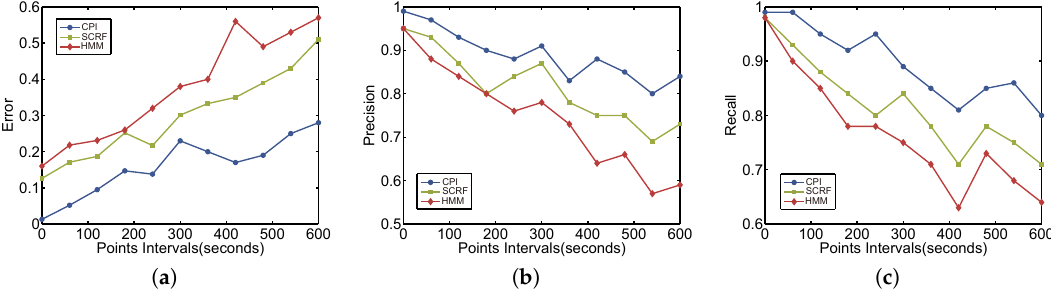
Figure 10. Experimental results by different sampling time intervals. ( a ) Error; ( b ) Precision; ( c ) Recall.